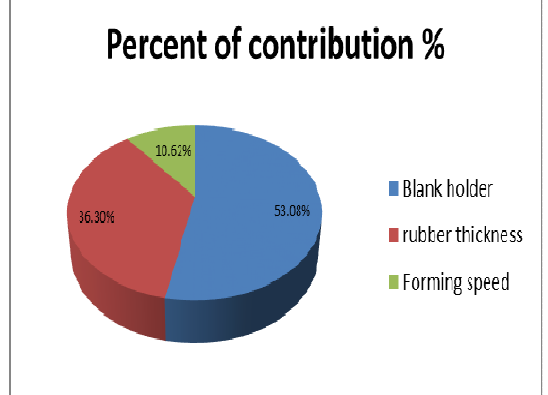
Fig. 11. The contribution of process parameters that effect on surface